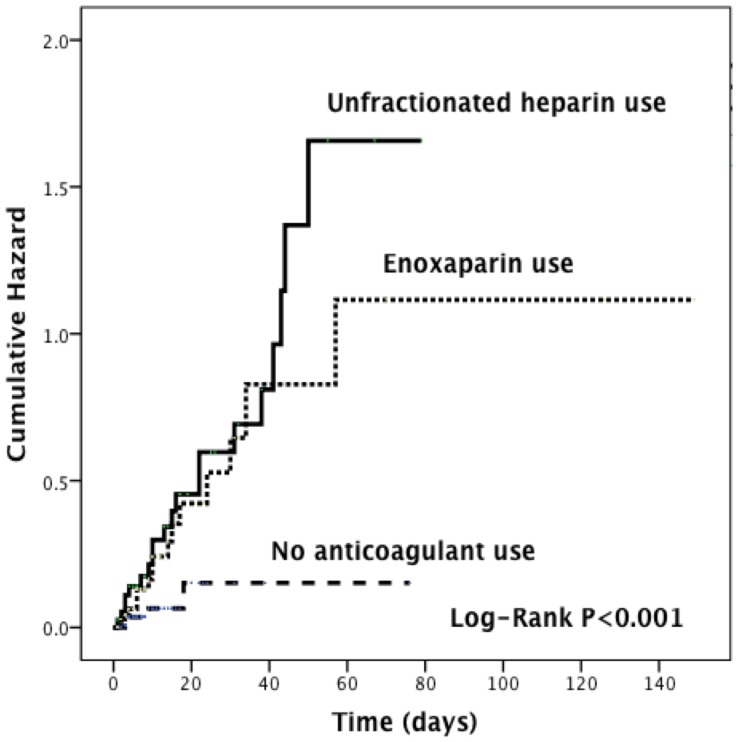
Kaplan-Meier estimates of cumulative hazard of major bleeding events with the use of unfractionated heparin or enoxaparin use.